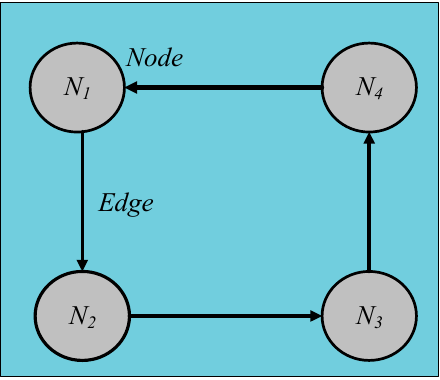
Figure 8. Communication network spanned across the microgrid to exchange information.